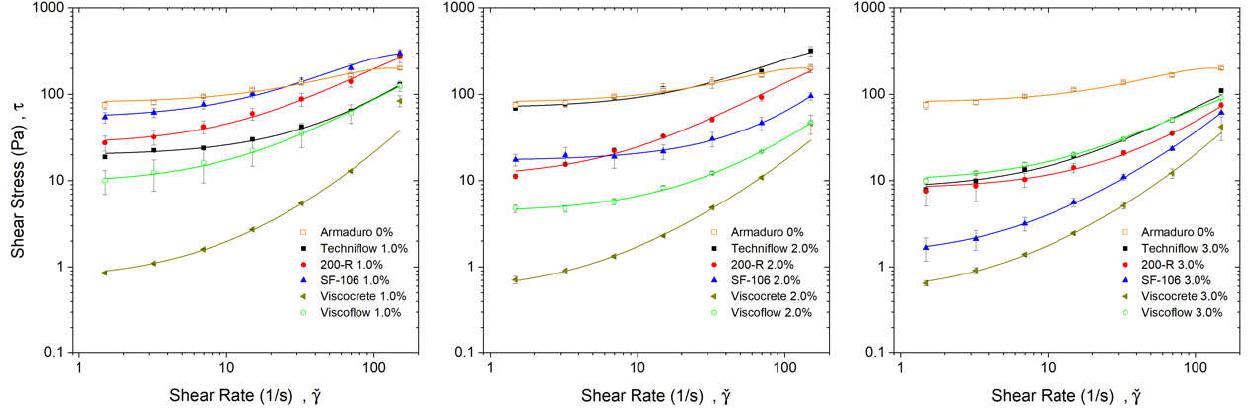
Figure 6. Effect of additive type and amount on SFCs of Armaduro cement pastes.